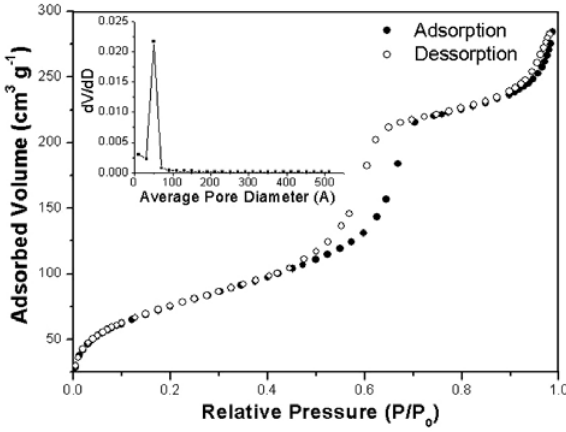
Figure 1. Nitrogen adsorption isotherms and average pore diameter for MS-AMP.